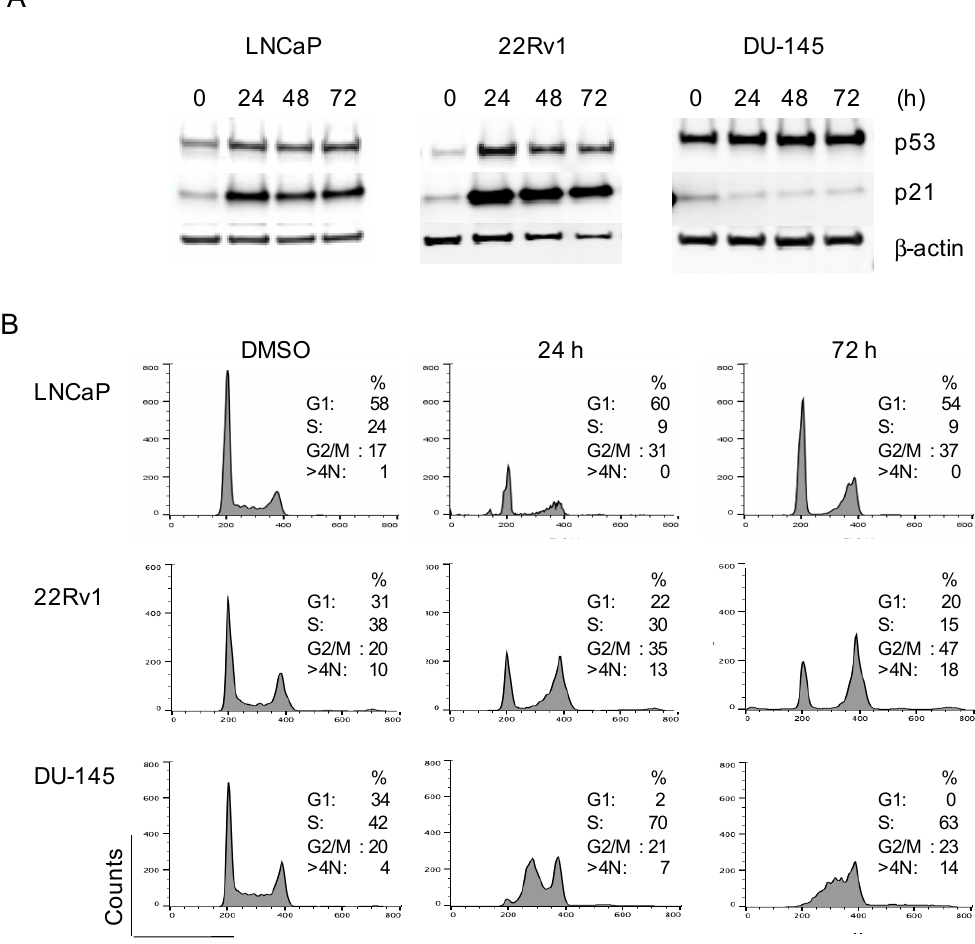
Figure 6. C-1311 blocks PCa cell cycle progression. ( A ) Western blotting analysis of p53 and p21 in PCa cells treated with 1 µ M C-1311 for the times indicated. β -actin was used as the loading control, n = 3. ( B ) Cell cycle profiles of the PCa cells treated as in ( A ), stained with PI and analysed by flow cytometry. Histograms are representative of three independent